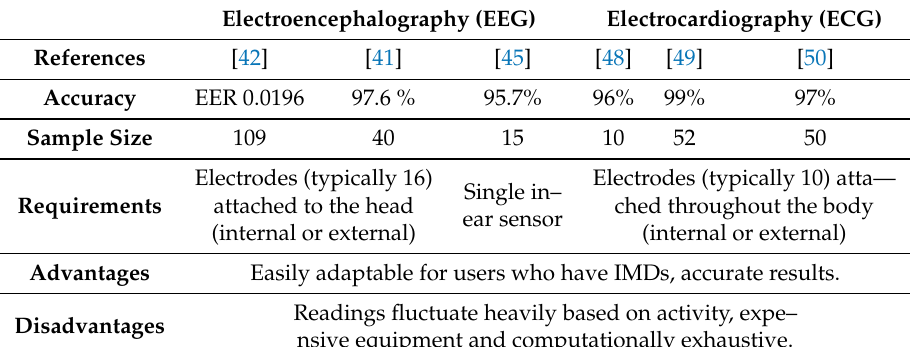
Table 6. Implantable Medical Device (IMD) Evaluation by